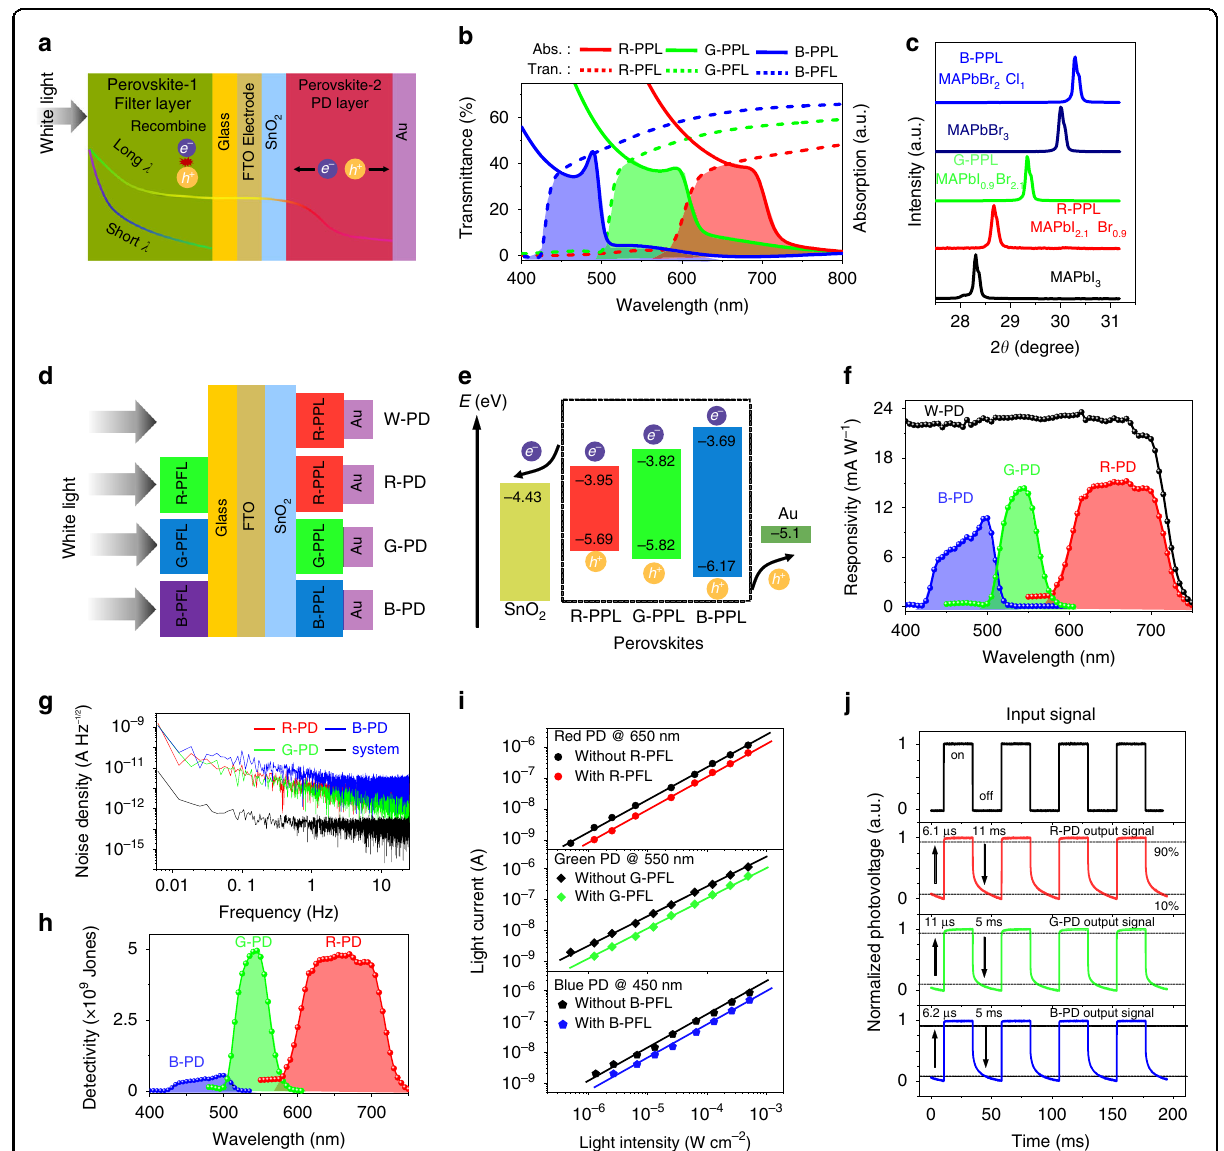
Fig. 2 Perovskite-based RGBW PDs. a Schematic of the narrowband perovskite PDs with PFL and PPL (conceptual illustration). b Experimental transmittance spectra of PFLs and experimental absorption spectra of the PPLs. c Experimental XRD patterns on a narrow scale of the MAPbX 3 (X = Cl, Br, I or mixed) perovskites for observing the trend of peak position change. d The device structure of the perovskite-based RGBW PDs (conceptual illustration). e Illustration of energy band of the RGB PPLs. f Experimental wavelength-dependent responsivity curves of the RGBW PDs. g Analysis of noise spectral density by Fourier transforming the experimental dark current waveform. h Wavelength-dependent speci fi c detectivity curves obtained by equation D* = R·A 1/2 /i n . i Light currents as a function of light intensity. j Transient photovoltage curves of the RGBD